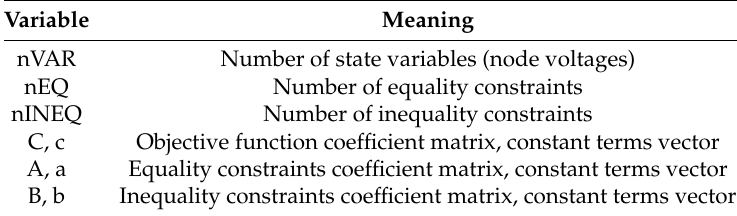
Table 1. Variables that form an OPF problem using